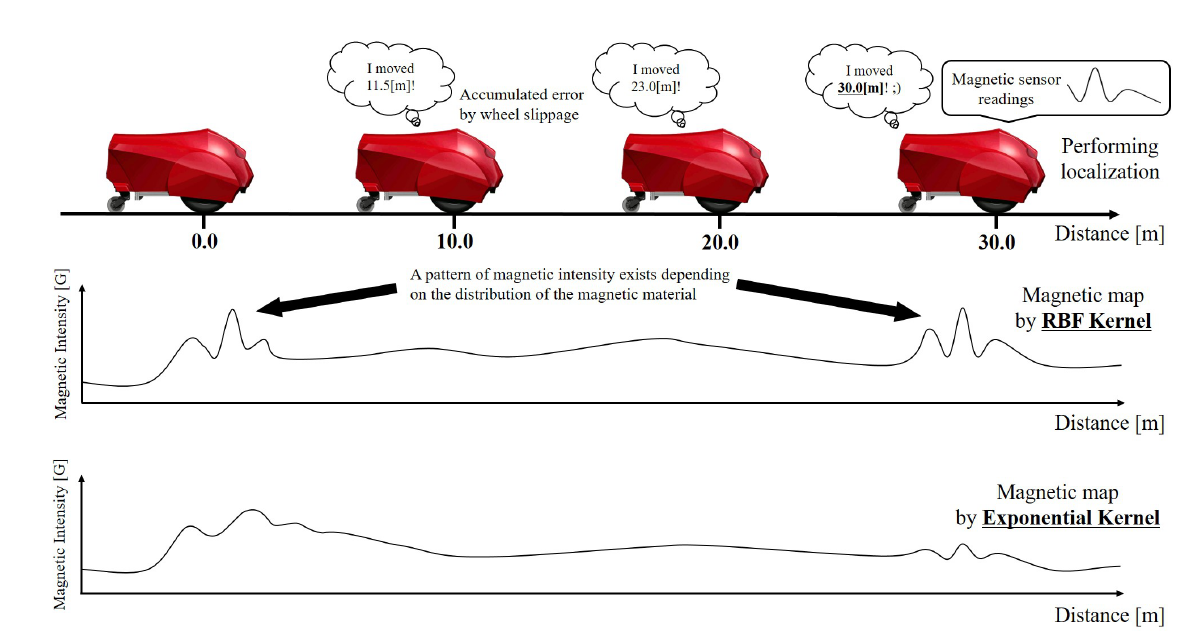
Figure 1. Travel distance estimation based on a magnetic fluctuation. The robot is given a magnetic map that stores the magnetic intensity with respect to